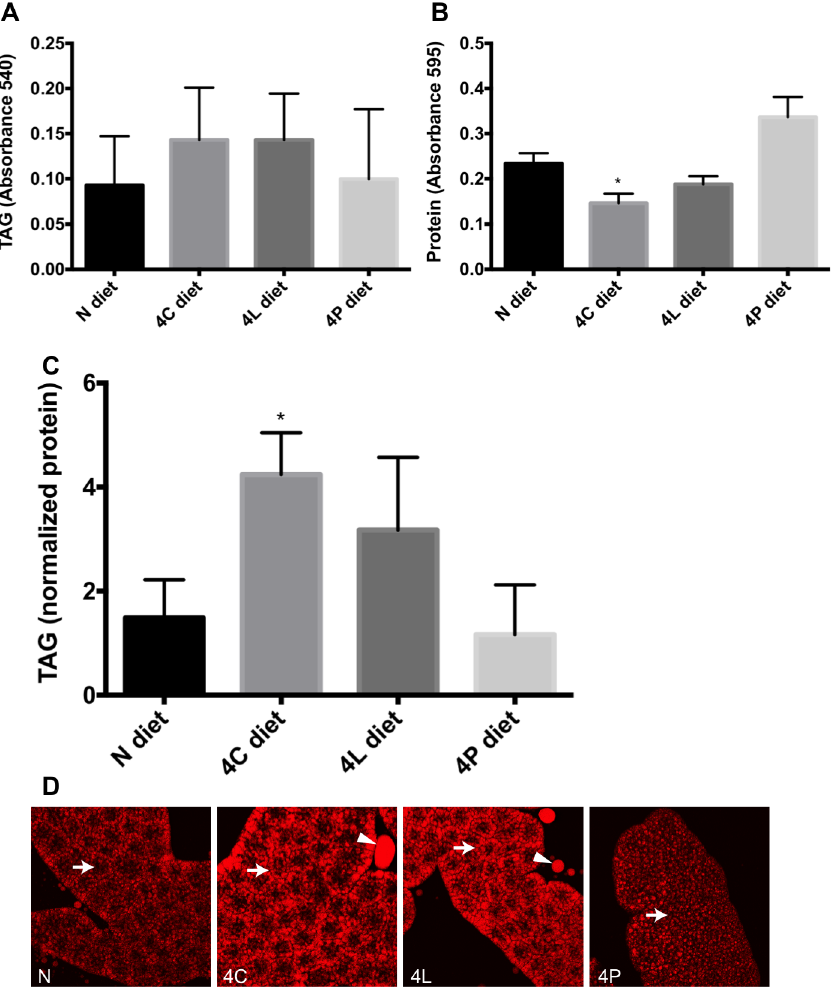
Fig 1. Effect of enriched diets on fat accumulation. Larvae were fed a balanced (N), carbohydrate-rich (4C), lipid-rich (4L) or protein-rich (4P) diet. (A-C) Larval extracts were analyzed for (A) total TAGs, (B) total soluble protein, or (C) total TAGs normalized for soluble protein. (D) Fat bodies of larvae were stained post- fixation for the fat-specific dye Nile Red (red). Fat bodies of larvae grown in 4C and 4L diets have higher levels of fat per cell (arrow), and commonly display “ leakage ” of fat from the isolated tissue (arrow head). Asterisks indicate significant differences (P < 0.05) for Ordinary one-way ANOVA. Error bars, standard deviation. Since in (C) the variances appeared unequal, both a nonparametric test (Mann Whitney) and a t test with Welch ’ s correction for unequal variances were also applied to these data. The Mann Whitney test found no significant difference (all P > 0.05) between the diets, whereas the Welch-corrected t test found significance only for the N-to-4C comparison (P =